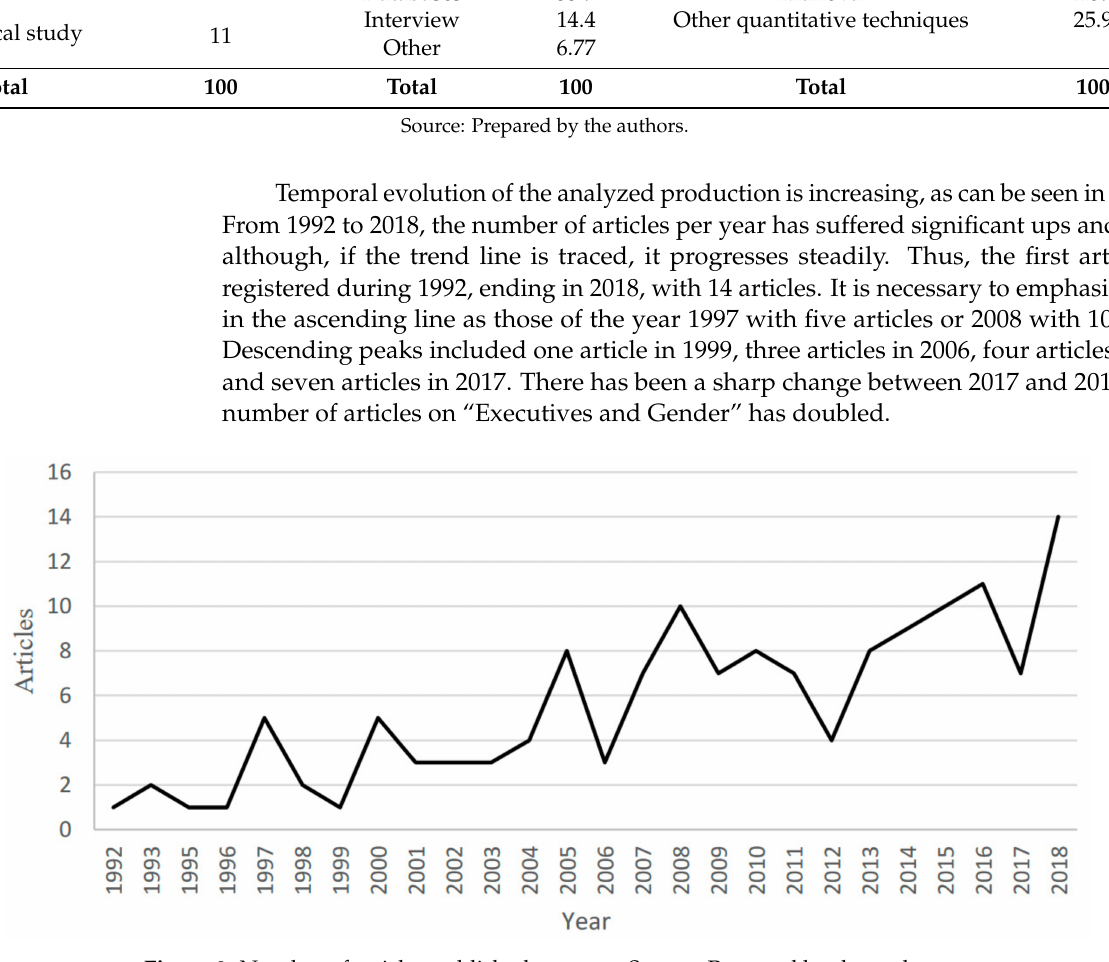
Figure 2. Number of articles published per year. Source: Prepared by the